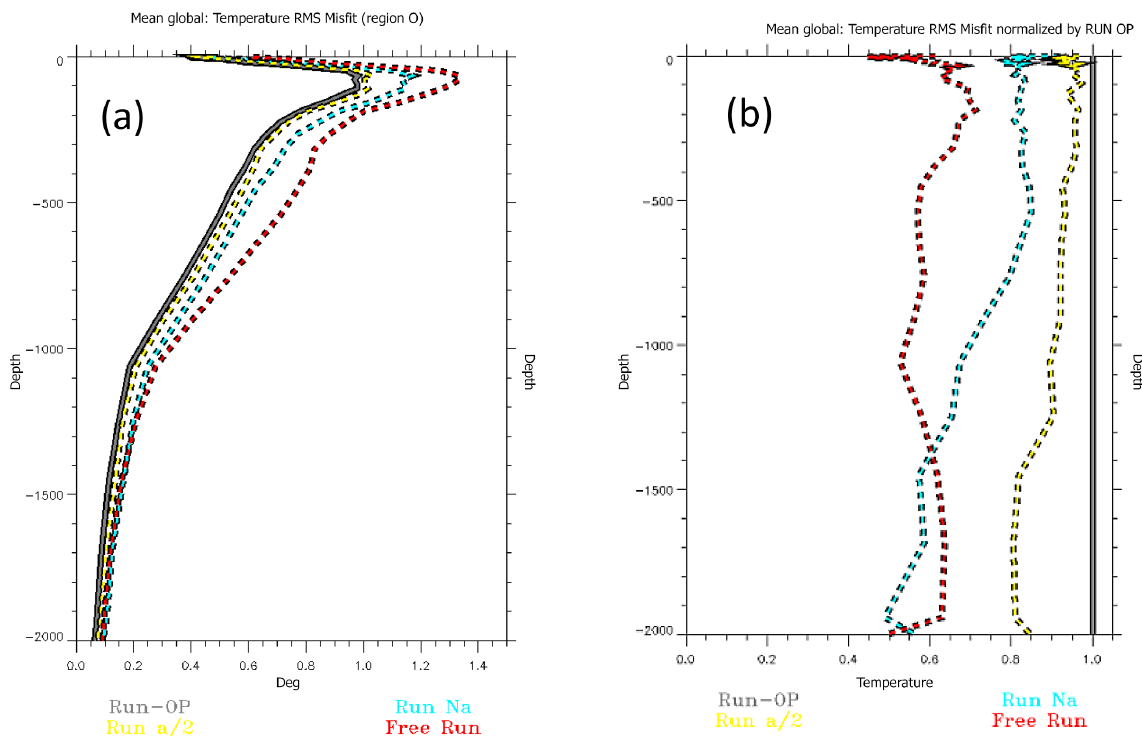
Figure 14. Vertical structure of the RMS of temperature innovations (a) and normalized RMS of temperature innovations (b) from 0–2000m for Run-Ref (grey), Run-Argo2 (yellow), Run-NoArgo (blue) and Free Run (red) over the last 6 months of the